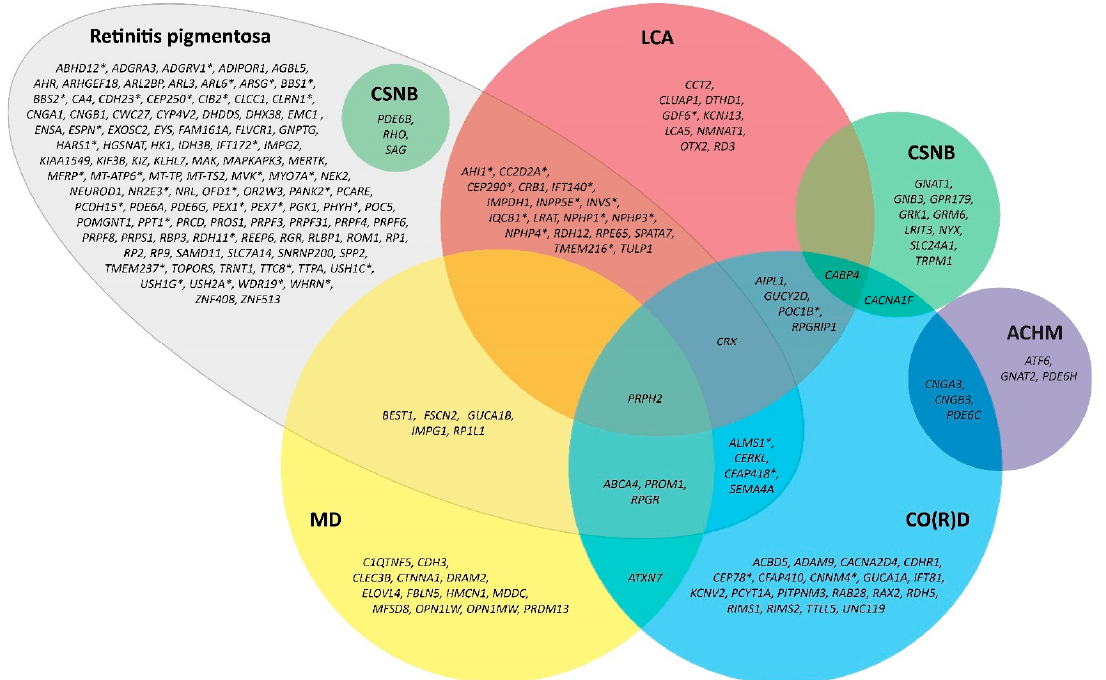
Figure 1. Venn diagram of currently identified genes associated with retinitis pigmentosa (RP) and their genetic overlap with other inherited retinal dystrophies. For example, variants in the RHO gene can manifest in either RP or congenital stationary night-blindness phenotypes. All genes included are registered in the Online Mendelian Inheritance in Man (OMIM) database and follow the up-to- date symbols of the HUGO Gene Nomenclature Commi tt ee (HGNC). Genes that are associated with syndromic forms of RP are marked with an asterisk (*). ACHM = achromatopsia; CO(R)D = cone(- rod) dystrophy; CSNB = congenital stationary night blindness; LCA = Leber Congenital Amaurosis; MD = macular dystrophy.